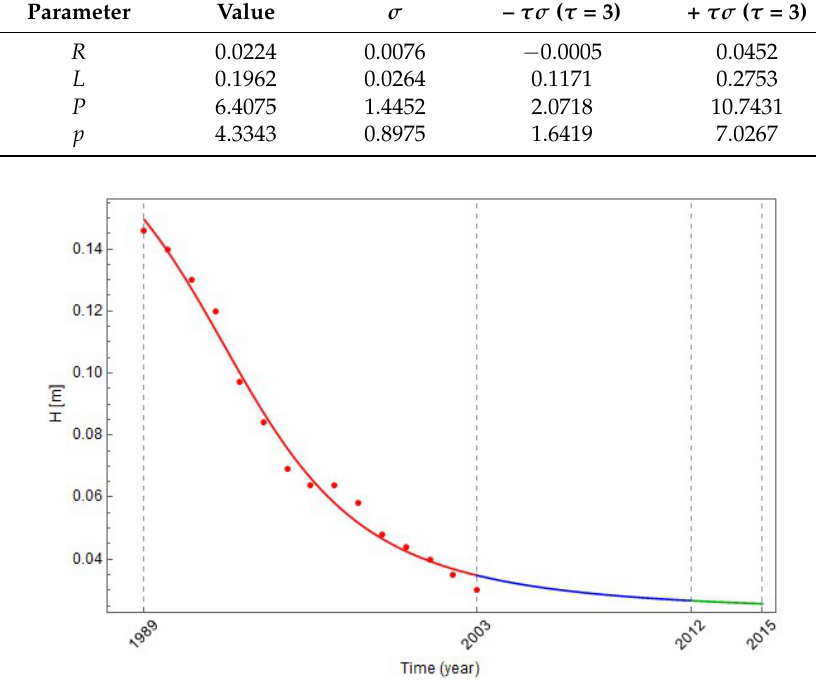
Figure 10. Graphical presentation of results from analysis of vertical displacement of point A5.